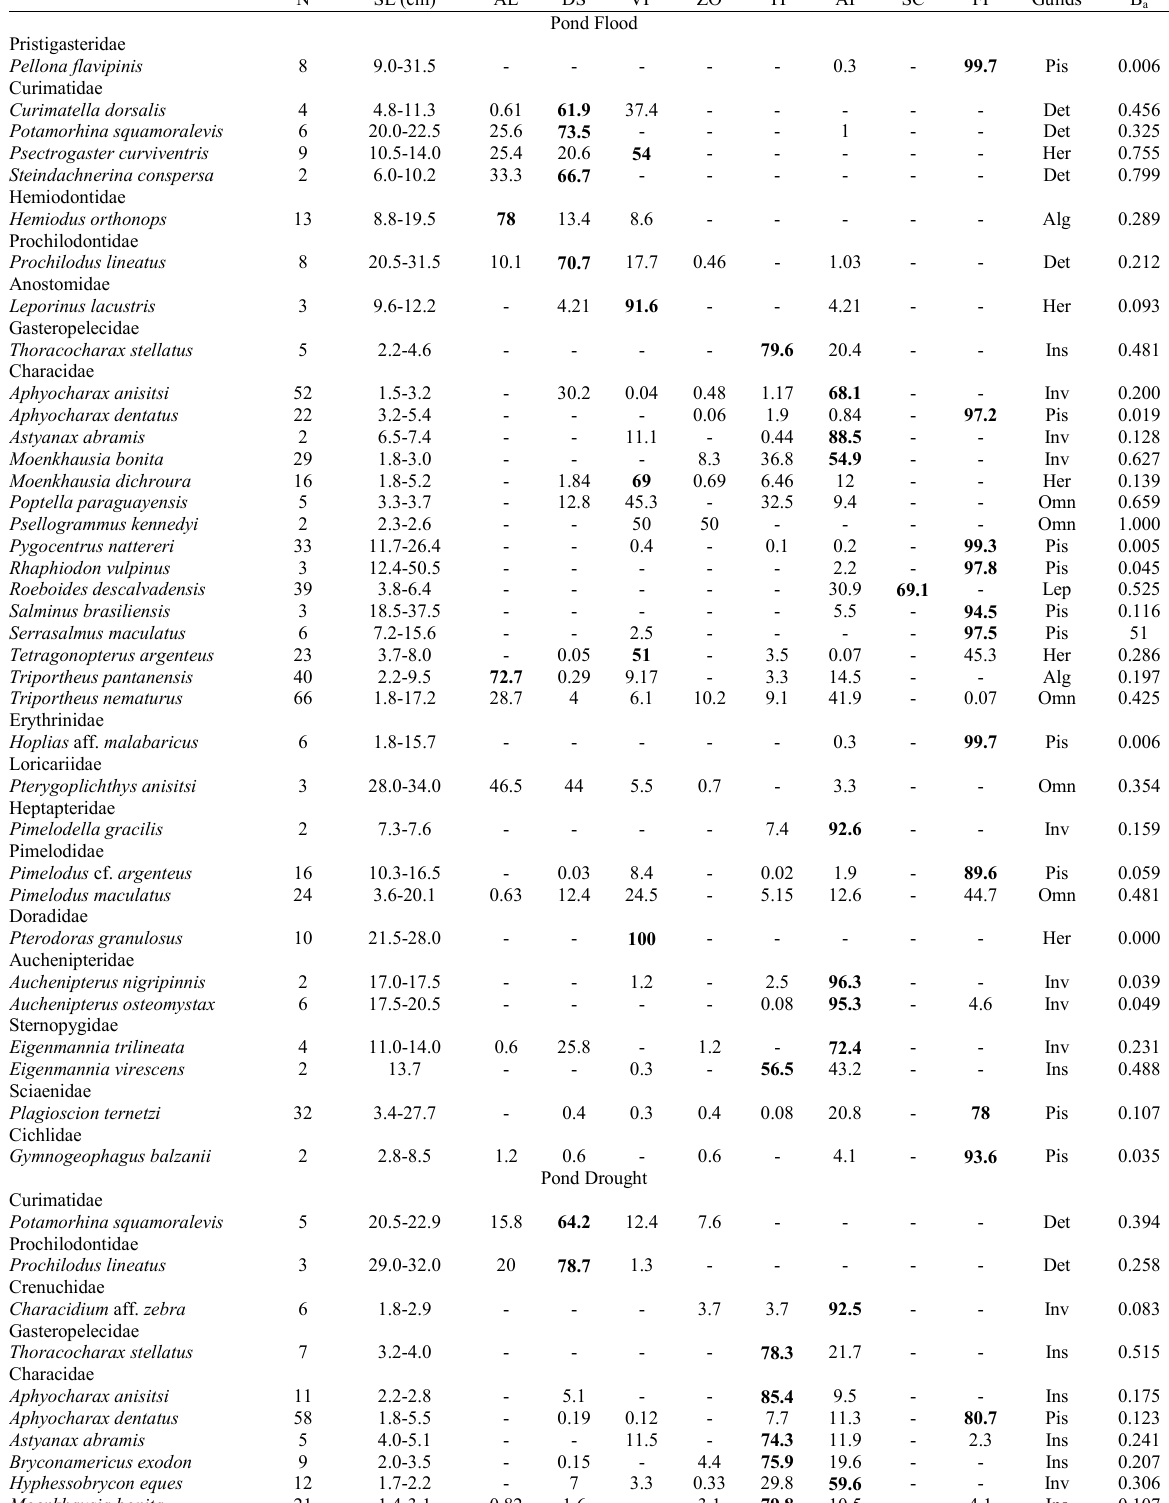
Table 1. Diet composition (volume %) of the fish fauna in the seasonal Brazilian Pantanal, Cuiabá River basin, Mato Grosso State, Brazil. N = stomach contents analyzed. SL = standard length. AL = algae, DS = detritus/sediment, HP = vascular plant, ZO = zooplankton, TI = terrestrial insects, AI = aquatic invertebrates. SC = scales, FI = fish. Number in bold indicate the main food resource (V > 51%). B = standardized trophic niche a